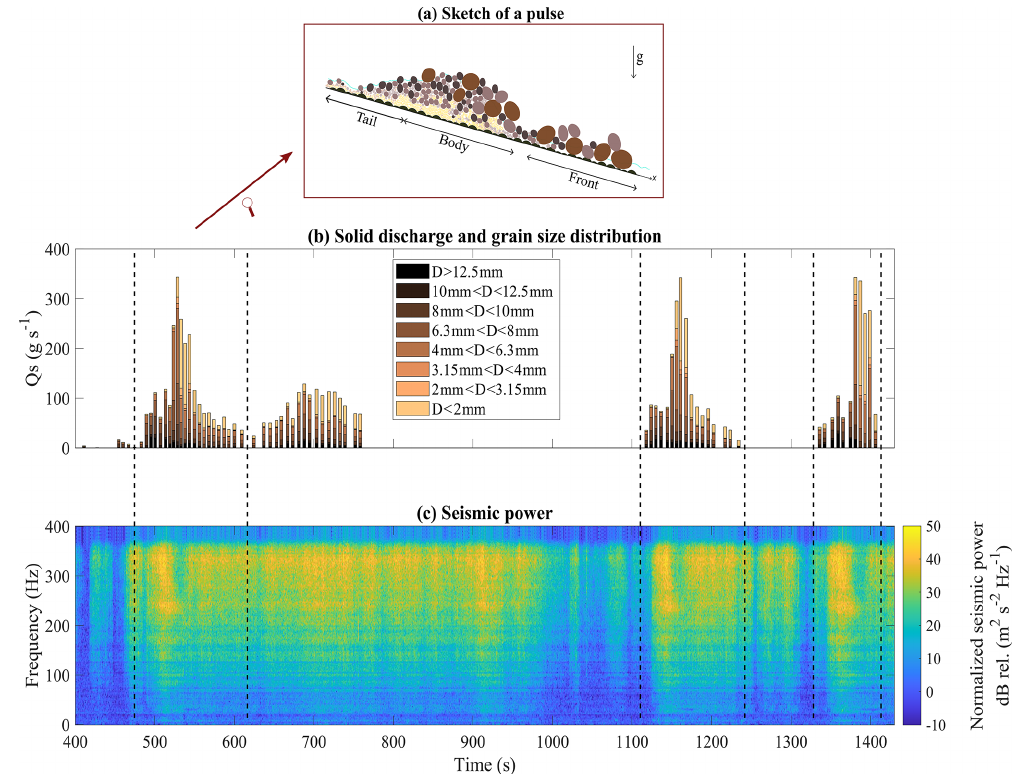
Figure 7. (a) Sketch of the sediment pulse. Sediment pulses can be divided into three parts: a front, a body, and a tail. (b) The four sampled pulses and the small solid discharge peak are presented with their grain size distribution. Each coloured bar refers to the particle diameter displayed in the legend, while the bar length is proportional to the percentage in weight of the related particle size. (c) Seismic power detected in the middle section of the flume. The seismic power is normalized with the mean seismic power computed under no sediment transport conditions, and it is shown as a function of time and frequency; different colours refer to different levels of